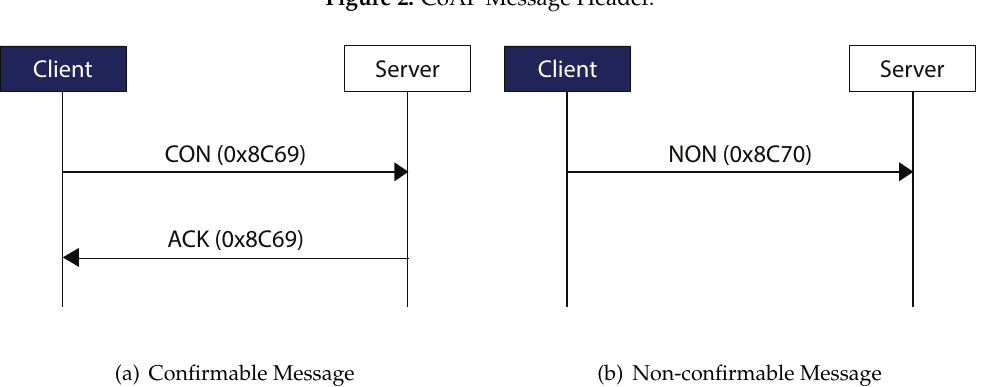
Figure 2. CoAP Message Header.